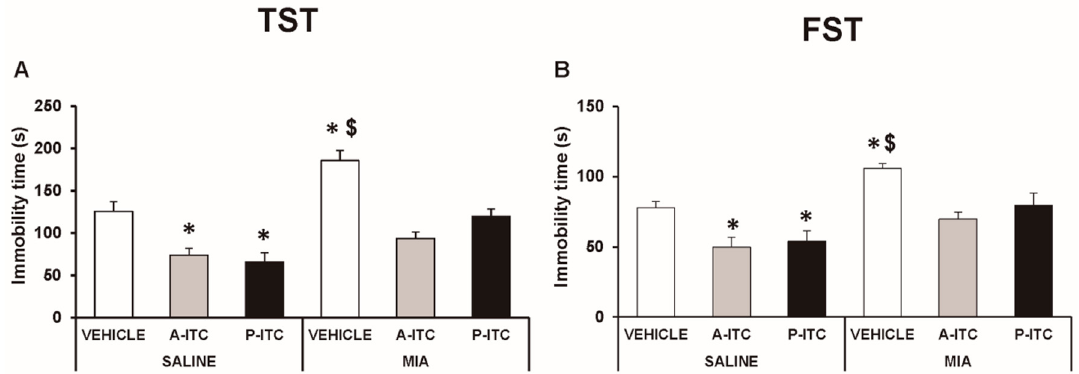
Figure 4. Treatment with A-ITC or P-ITC decreases the depressive-like behaviors associated with chronic osteoarthritis pain. The immobility time (s) evaluated with the ( A ) tail suspension test (TST) and ( B ) forced swimming test (FST) at 29 days after MIA or SS injection in mice treated for 4 consecutive days with A-ITC or for 10 days with P-ITC is shown. For each test evaluated, * denotes significant differences vs. SS-injected mice treated with vehicle, and $ denotes significant differences vs. MIA-injected mice treated with a drug ( p < 0.05; one-way ANOVA followed by the Student–Newman–Keuls test). The results are presented as the mean values ± SEM; n = 10 animals per experimental group.